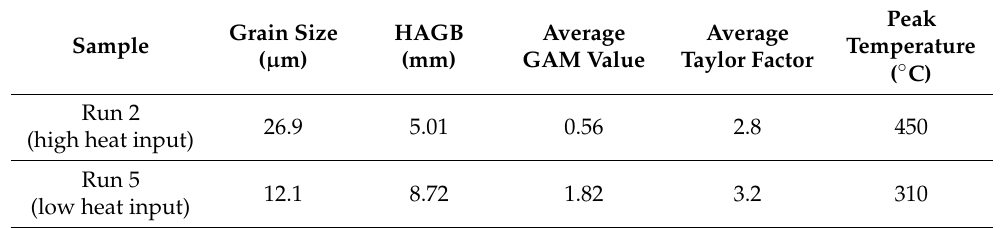
Table 5. EBSD data in conjunction with peak temperatures of the joints welded at the conditions of experiment numbers 2 (high heat input) and 5 (low heat